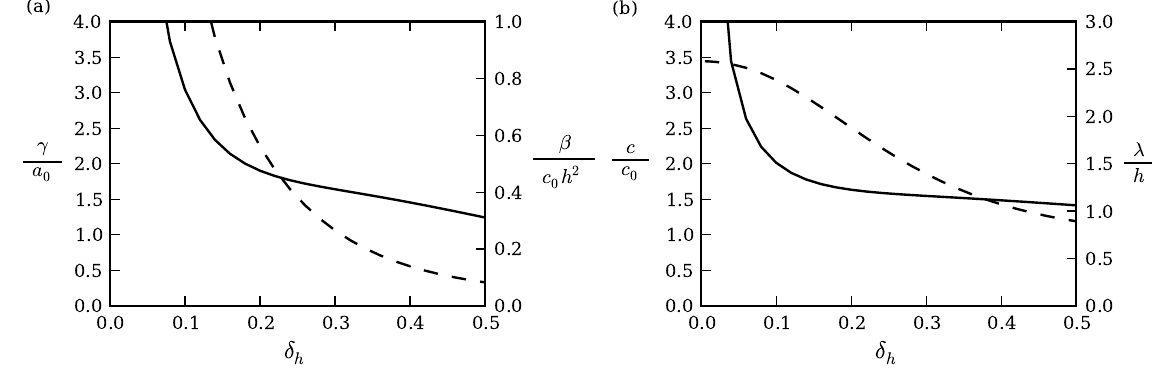
Fig. 3. (a) Coefficients of the KdV equation as functions of interface thickness. The nonlinear coefficient, γ , is shown by the solid line and the dispersion coefficient, β , is shown by the dashed line. (b) The speed, c , (solid line) and width, λ , (dashed line) of a rectilinear solitary wave as a function of interface